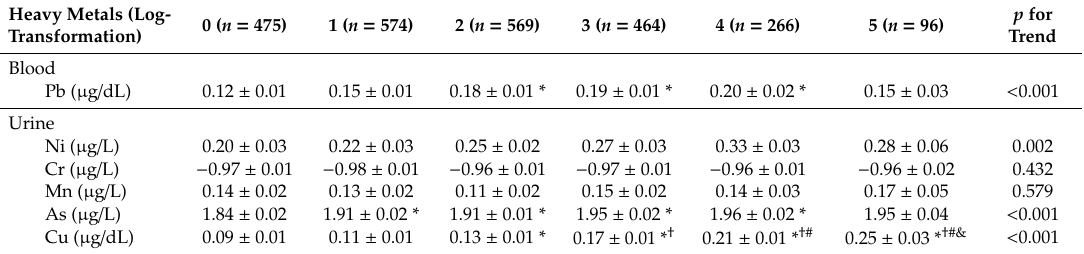
Table 3. Heavy metal values according to the sum of components of MetS in study participants.